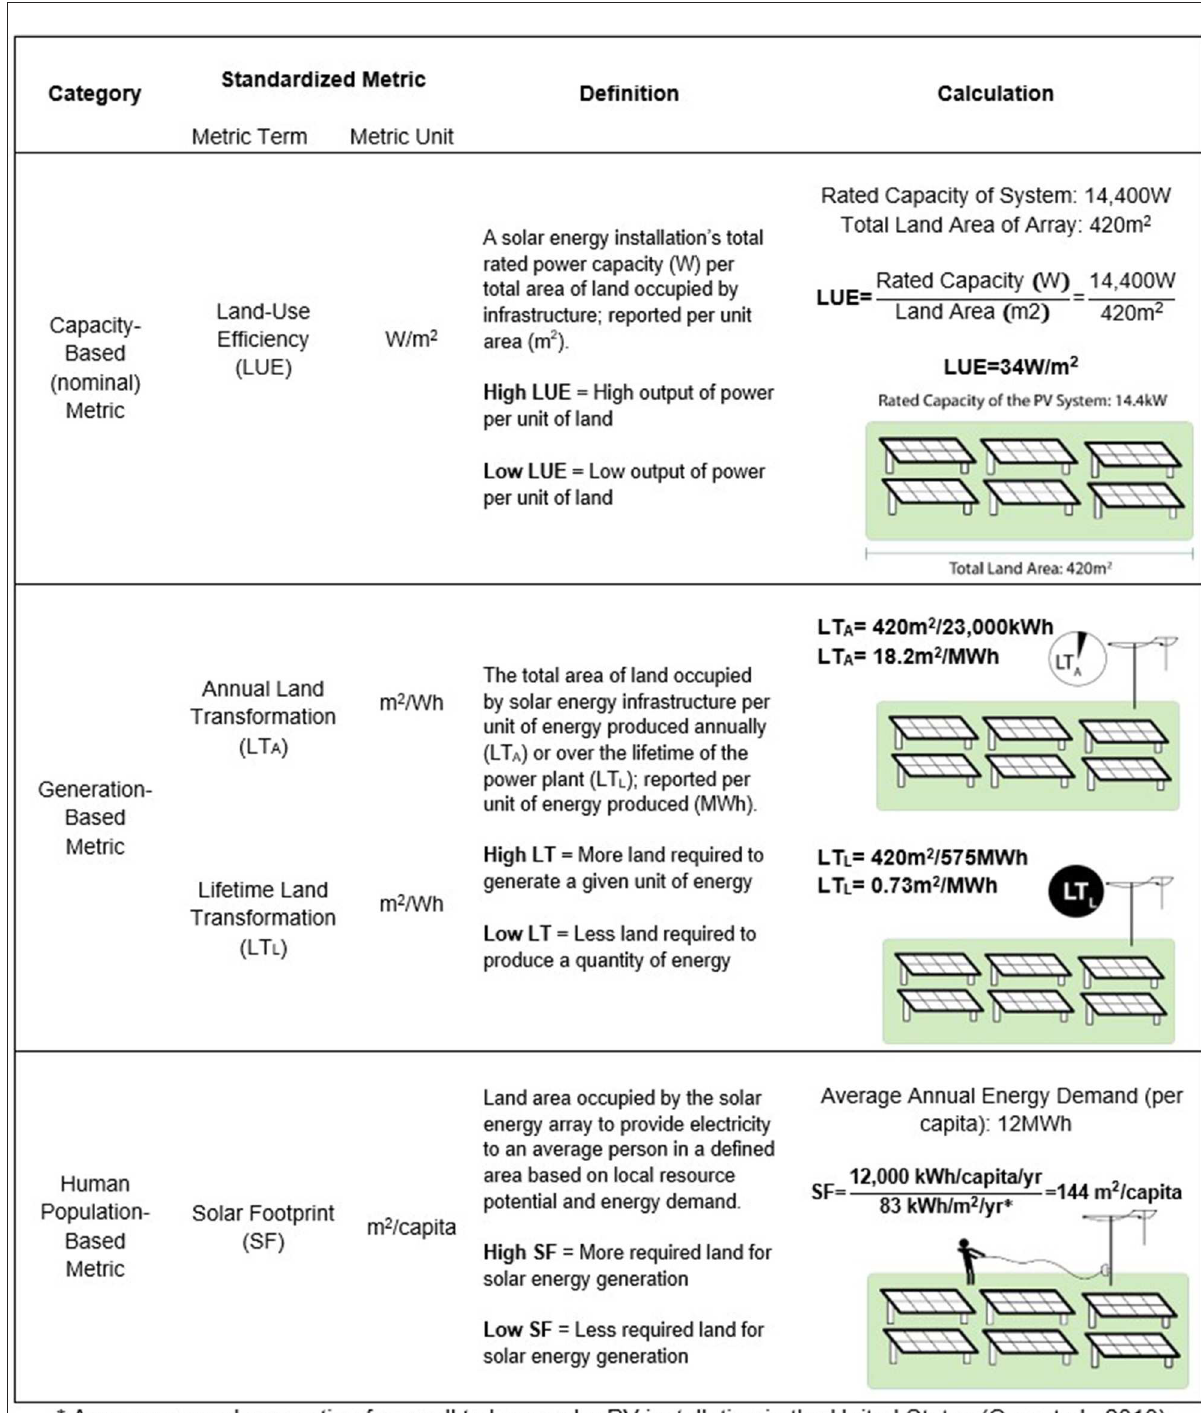
FIGURE5 Standardized solar energy-land metrics for capacity-based, generation-based, and human population-based applications, including their definition and